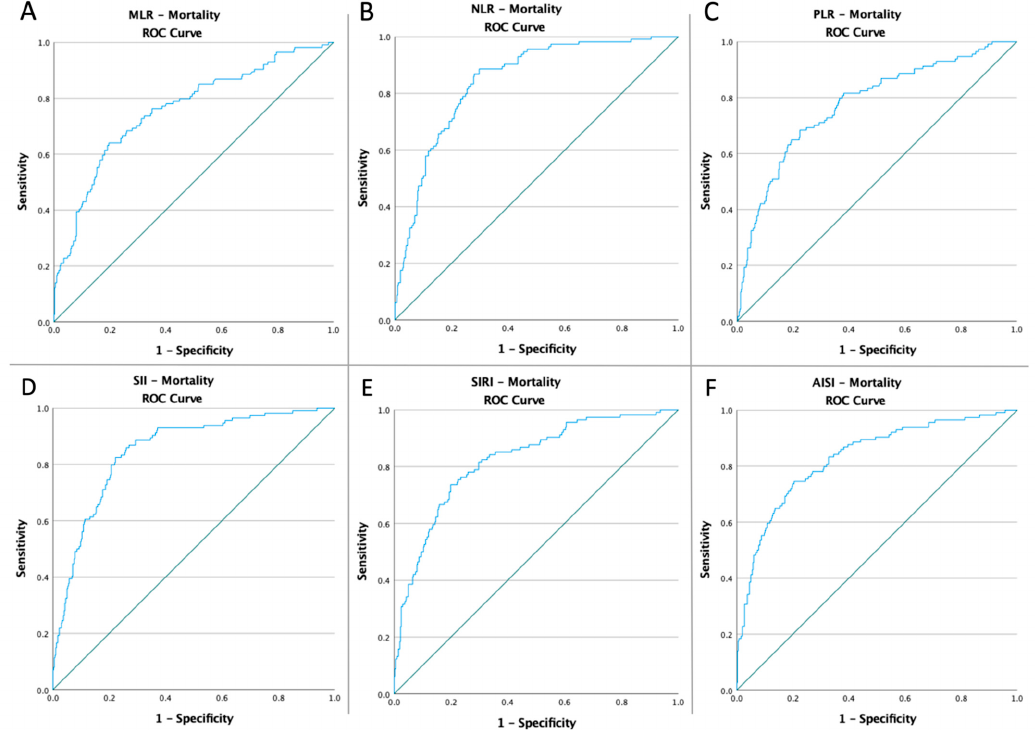
Figure 3. ROC curve analysis concerning the mortality ( A ) MLR (AUC: 0.829; p < 0.0001), ( B ) NLR (AUC: 0.856; p < 0.0001), ( C ) SII (AUC: 0.858; p < 0.0001), ( D ) SIRI (AUC: 0.785; p < 0.0001), ( E ) AISI